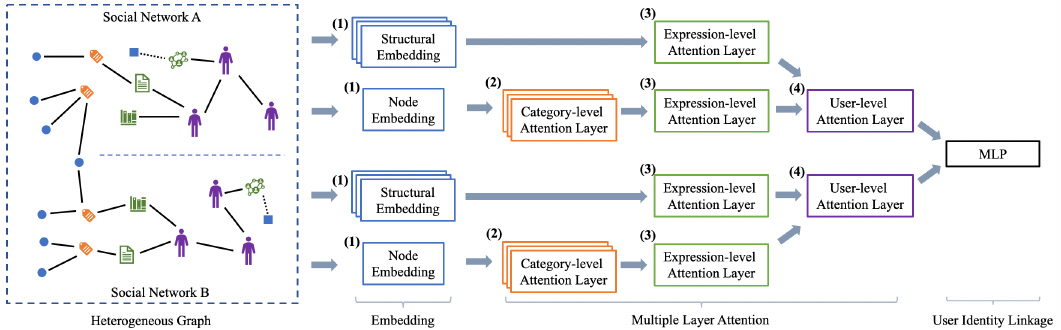
Figure 3. User identity linkage method based on a heterogeneous graph attention network mechanism